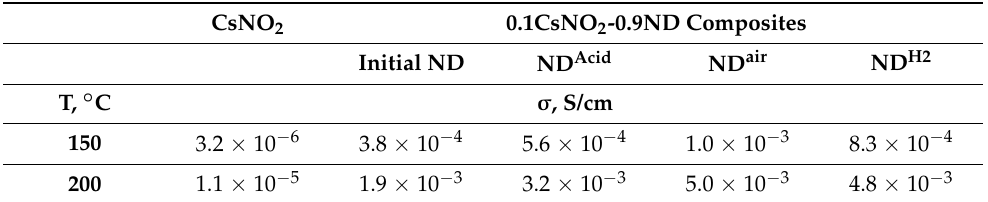
Table 2. Comparison of the conductivity values for pure CsNO 2 and composite solid